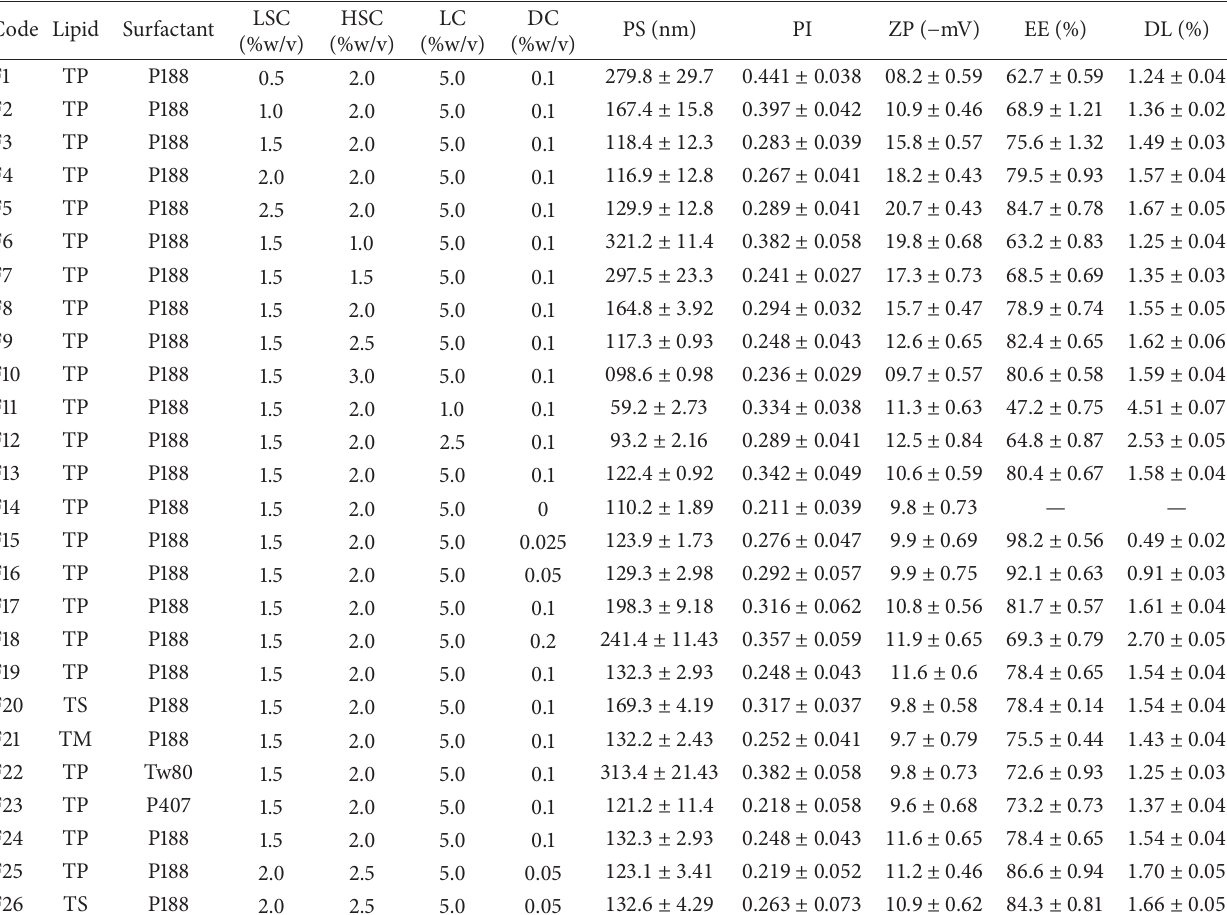
Table 2: Formulation composition and the effect of different formulation variables on particle size (PS), polydispersity index (PI), zeta potential (ZP), entrapment efficiency (EE), and drug loading